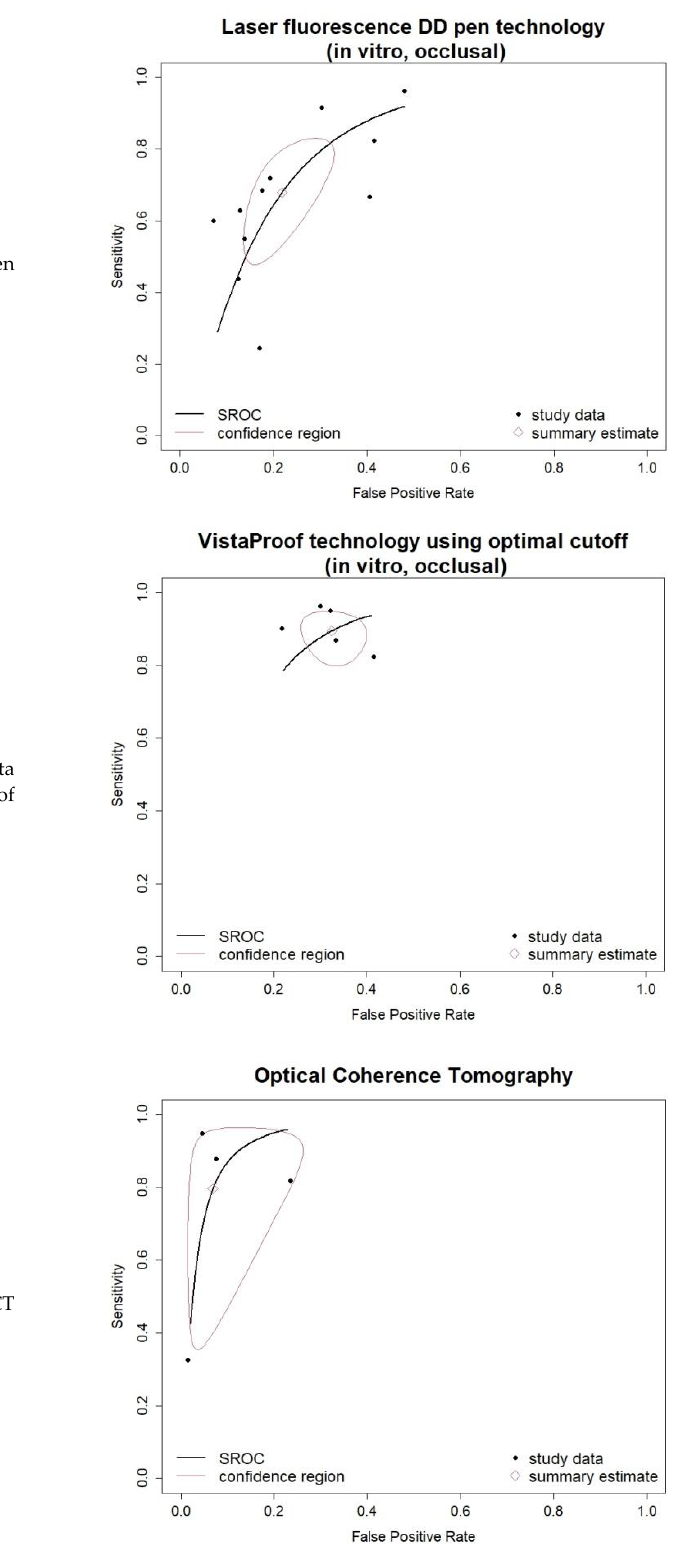
vitro; OCT overall. ( a ) Log DOR forest plots and random effects aggregate estimates. ( b ) Log DOR funnel plots to illustrate the publication bias as patterns of individual studies clustering around the mean effect.